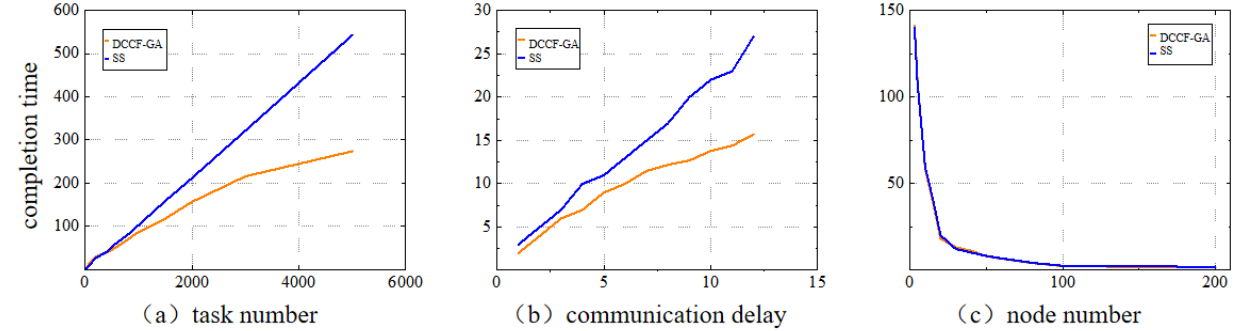
Figure 8. Performance comparison of DCCF-GA and SS in completion time. ( a ) Comparing the completion time of DCCF-GA and SS when the number of tasks is different; ( b ) Comparing the completion time of DCCF-GA and SS when communication delay is different. ( c ) Comparing the completion time of DCCF-GA and SS when the number of satellite nodes is different.